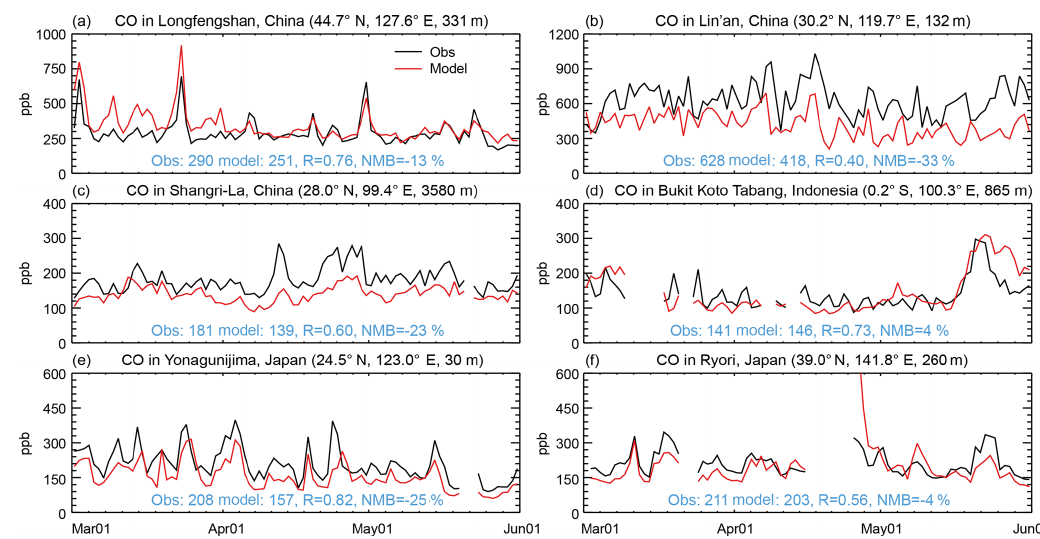
Figure 5. Time series of daily mean CO at six surface sites over (a–c) China and (d–f) nearby